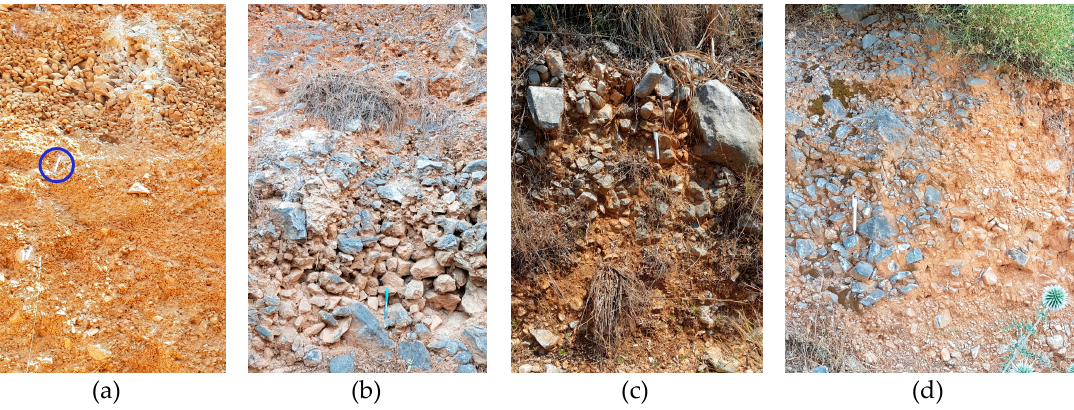
Figure 3. ( a ) Colluvium with voids and matrix-supported colluvium; ( b ) colluvium with medium size voids; ( c ) large carbonate clasts; ( d ) matrix supported small to medium size colluvium.